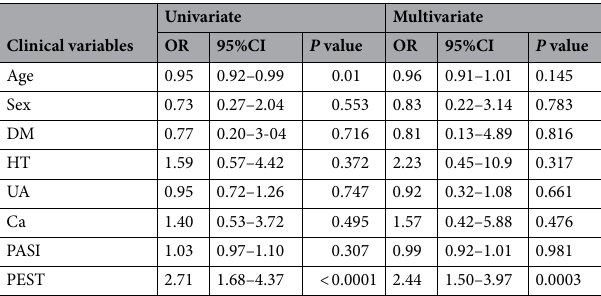
Table 5. Univariate and multivariate analysis for clinical